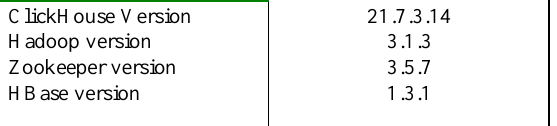
Table 5 . Node configuration for